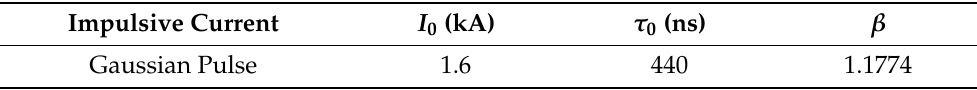
Table 2. Parameters of a Gaussian pulse that has a FWHM of 1